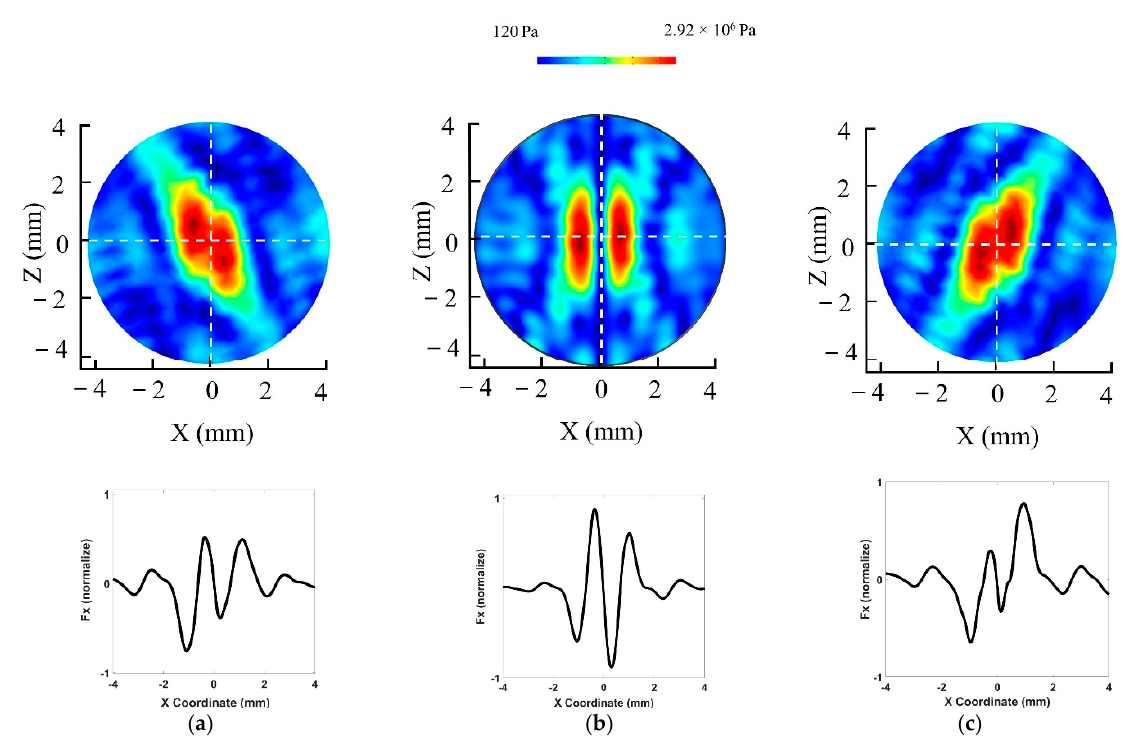
Figure 5. Acoustic pressure field at the trapping point with a 50 Vpp difference between two sides of the tweezer. ( a ) Excitation voltages are 60 and 10 Vpp for the left and right sides, respectively. ( b ) Excitation voltages for both sides of system are 60 Vpp. ( c ) Excitation voltage on the left side is 10 Vpp and that on the right side 60 Vpp.